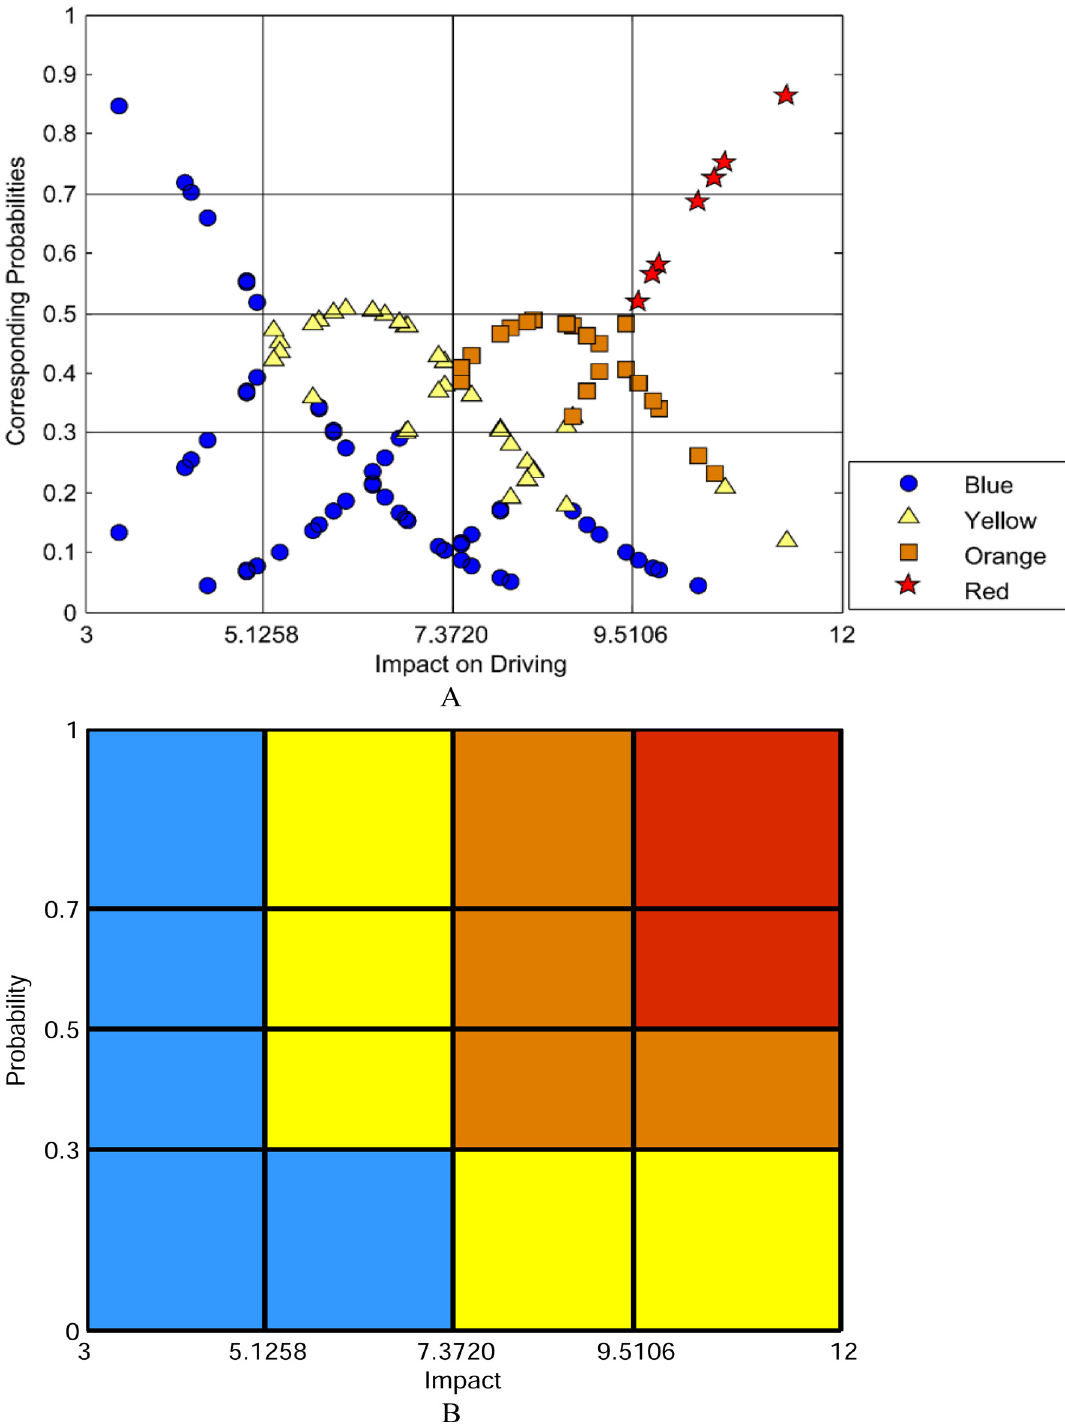
Fig 4. Conducting the risk matrix of driving on freeway under rainy weather conditions. Panel A shows distribution of early warning colors of weighted driving risk.Panel B shows risk matrix with combined effects of impact and probability.